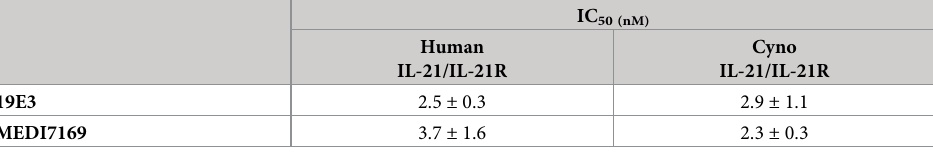
Table 3. MEDI7169 inhibition of human or cyno IL-21/IL-21R-Fc interactions.